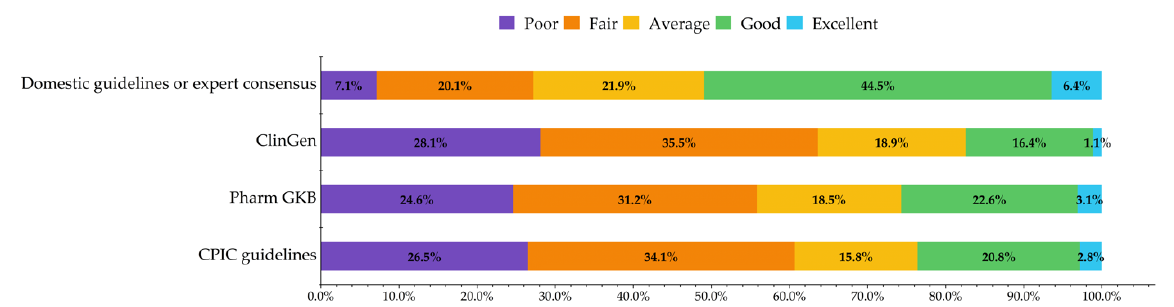
Figure 2. Knowledge about PGx-related guidelines, monographs, and databases.